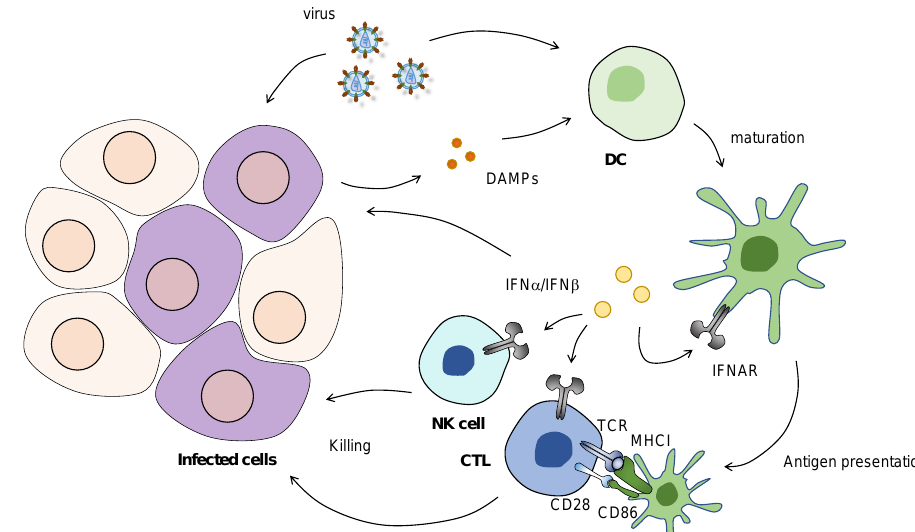
Figure 1. The role of type I IFNs in the interplay between innate immunity and T cell-mediated antiviral immunity. Upon viral infection, direct recognition of viral nucleic acids by dendritic cells (DCs) and danger signals from infected cells can induce antiviral responses. When activated, DCs undergo maturation to express costimulatory molecules, such as CD86. In draining lymph nodes, these DCs act as antigen-presenting cells presenting viral antigens to CD8 T cells through dependence on MHC-I. Simultaneously, type I IFNs (e.g., IFN α and IFN β ) produced by innate immune and infected cells further activate CTLs and NK cells to enhance cytotoxicity. Type I IFNs also act on infected cells and neighboring cells, in an autocrine and paracrine fashion, which promotes apoptosis of infected cells and renders uninfected cells resistant to viral infection. CTL; cytotoxic T